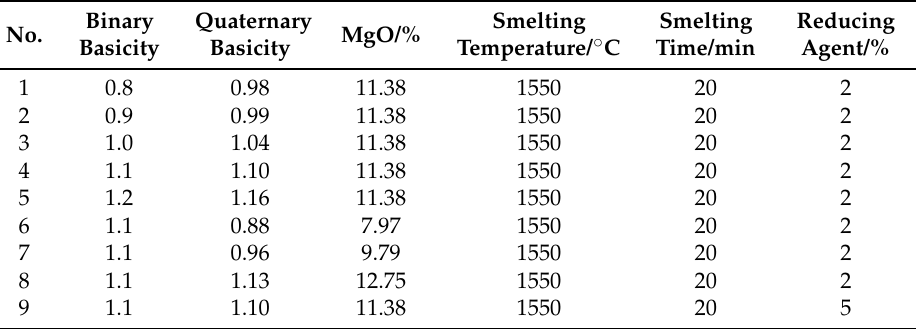
Table 2. Titanium slag composition and smelting parameters.